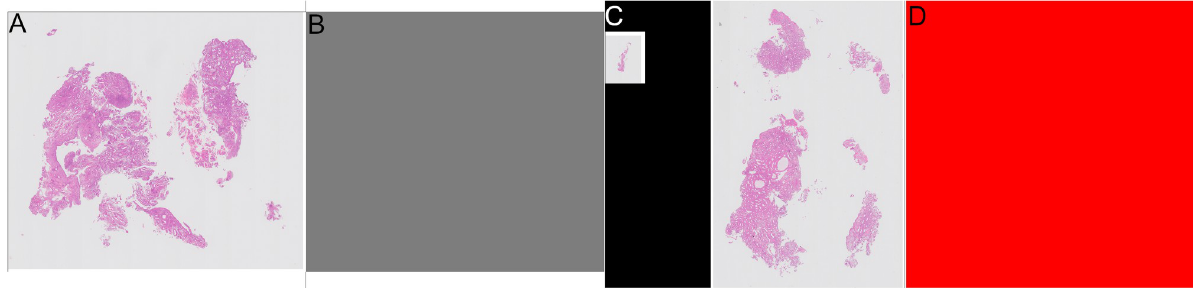
Fig 2. Examples of annotations for slides where all tissue the same category. Grey areas show “other or benign” category, red areas show “malignant” category. (A) Slide where all tissue is “other or benign”. (B) Annotation for slide where all tissue is “other or benign”. (C) Slide where all tissue is “malignant”. (D) Annotation for slide where all tissue is